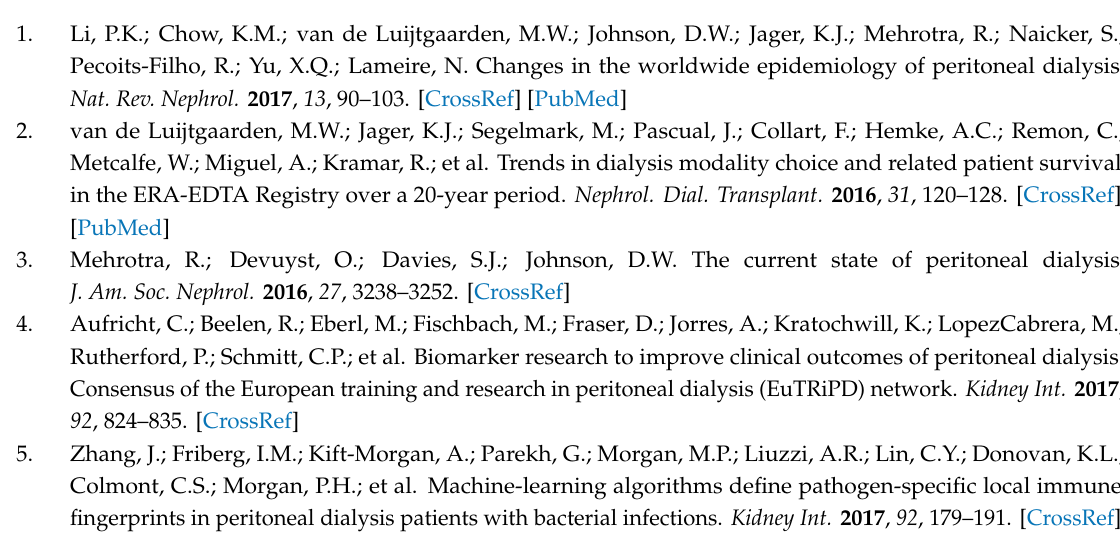
Figure S1: PCA score plot from FTIR data based on the polysaccharide spectral region (1200–800 cm − 1 ); Tables S1–S3: Confusion matrix incl. classification rates of (S1) patient-related data (balanced), (S2) PD-related data (balanced), and (S3) immune system-related data